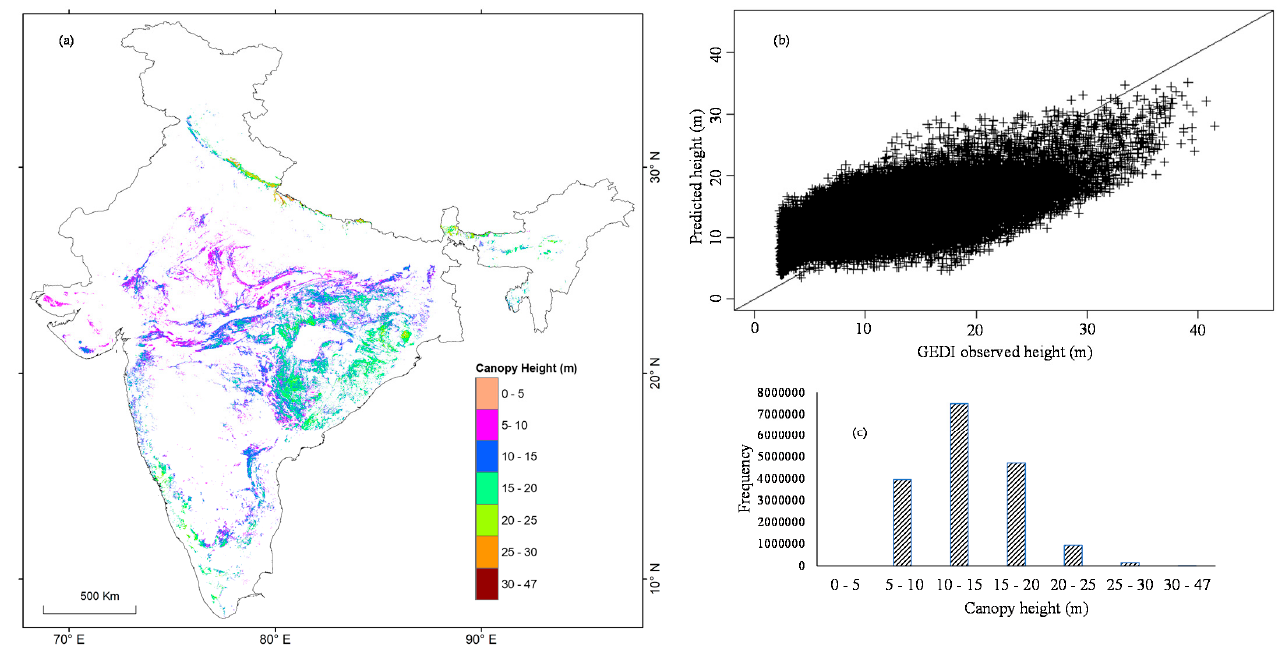
Figure 4. ( a ) GEDI predicted forest canopy height map, ( b ) the RF model predicted vs. the field- estimated height plot using GEDI data and ( c ) histograms showing the canopy height distribution for the deciduous forests.